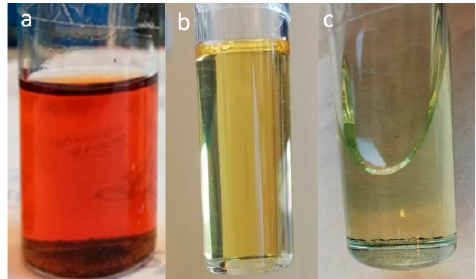
Figure 1. Reaction mixture after cyclocarbonylation of 2-methyl-3-buten-2-ol to 4,4-dimethyl- γ -butyrolactone ( a ) without IL and 16 mol% DPEphos, ( b ) with 1.0 g IL [BMIM]Cl and 16 mol% DPEphos, and ( c ) with 1.0 g IL [BMIM]Cl and 4 mol% DPEphos. Reaction conditions: 0.1 M 2-methyl-3-buten-2-ol, 4 mol% Pd(OAc) 2 , 5 mL DCM, 95 ° C, 28 bar (CO/H 2 : 23/5), 18 h.